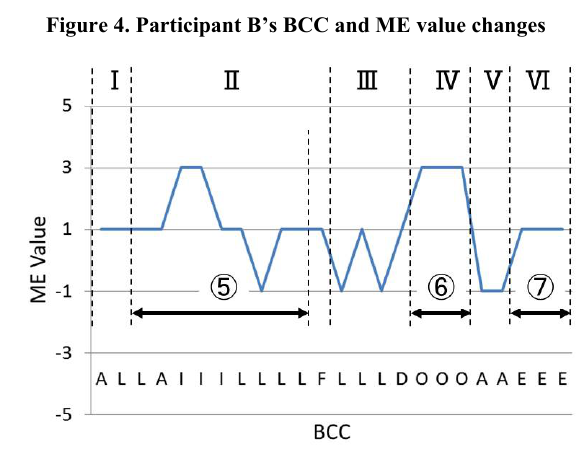
Figure 5. Participant C’s BCC and ME value